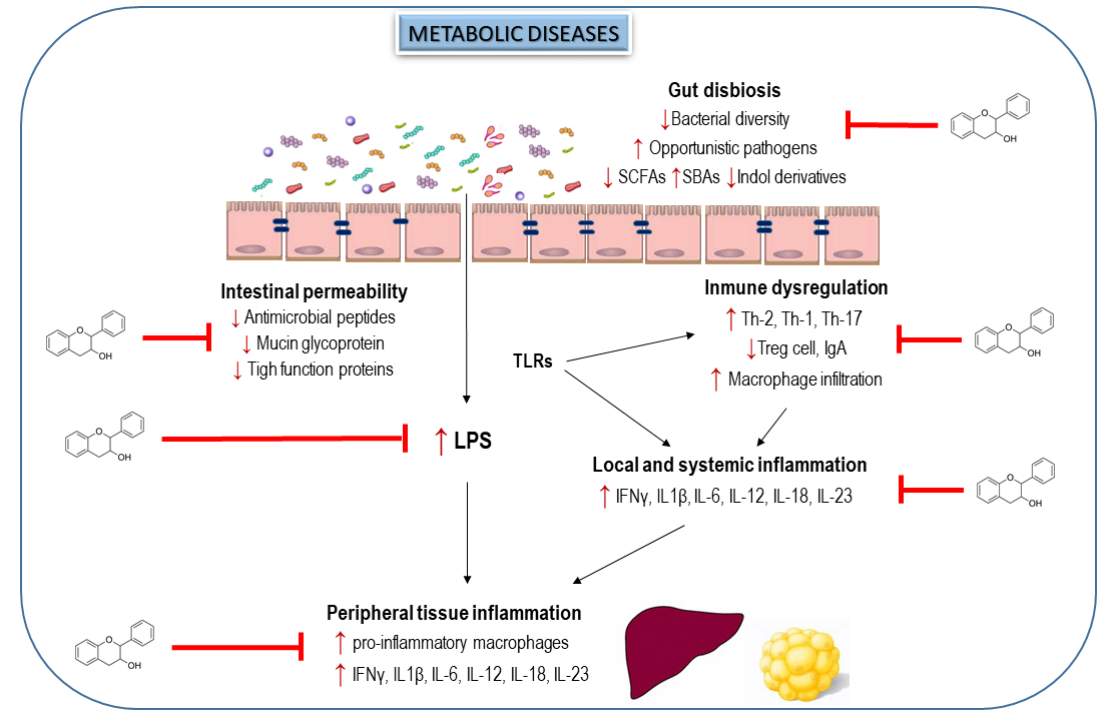
Figure 3. Effects of flavanols and flavanol-rich food on alterations in gut microbiota, immune system and inflammation during metabolic disorders. Up arrows indicate a rising trend and down arrows display a decreasing trend. Flavanols modulate gut dysbiosis, improve gut barrier function and the immune system and reduce serum endotoxin minimizing intestinal, hepatic and adipose inflammation.